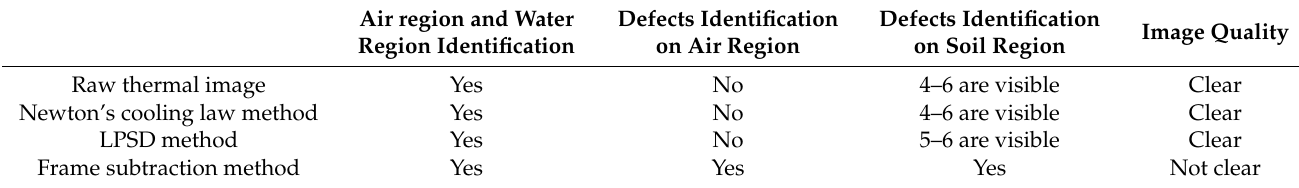
Table 8. Summary of merits and demerits of each method in Case